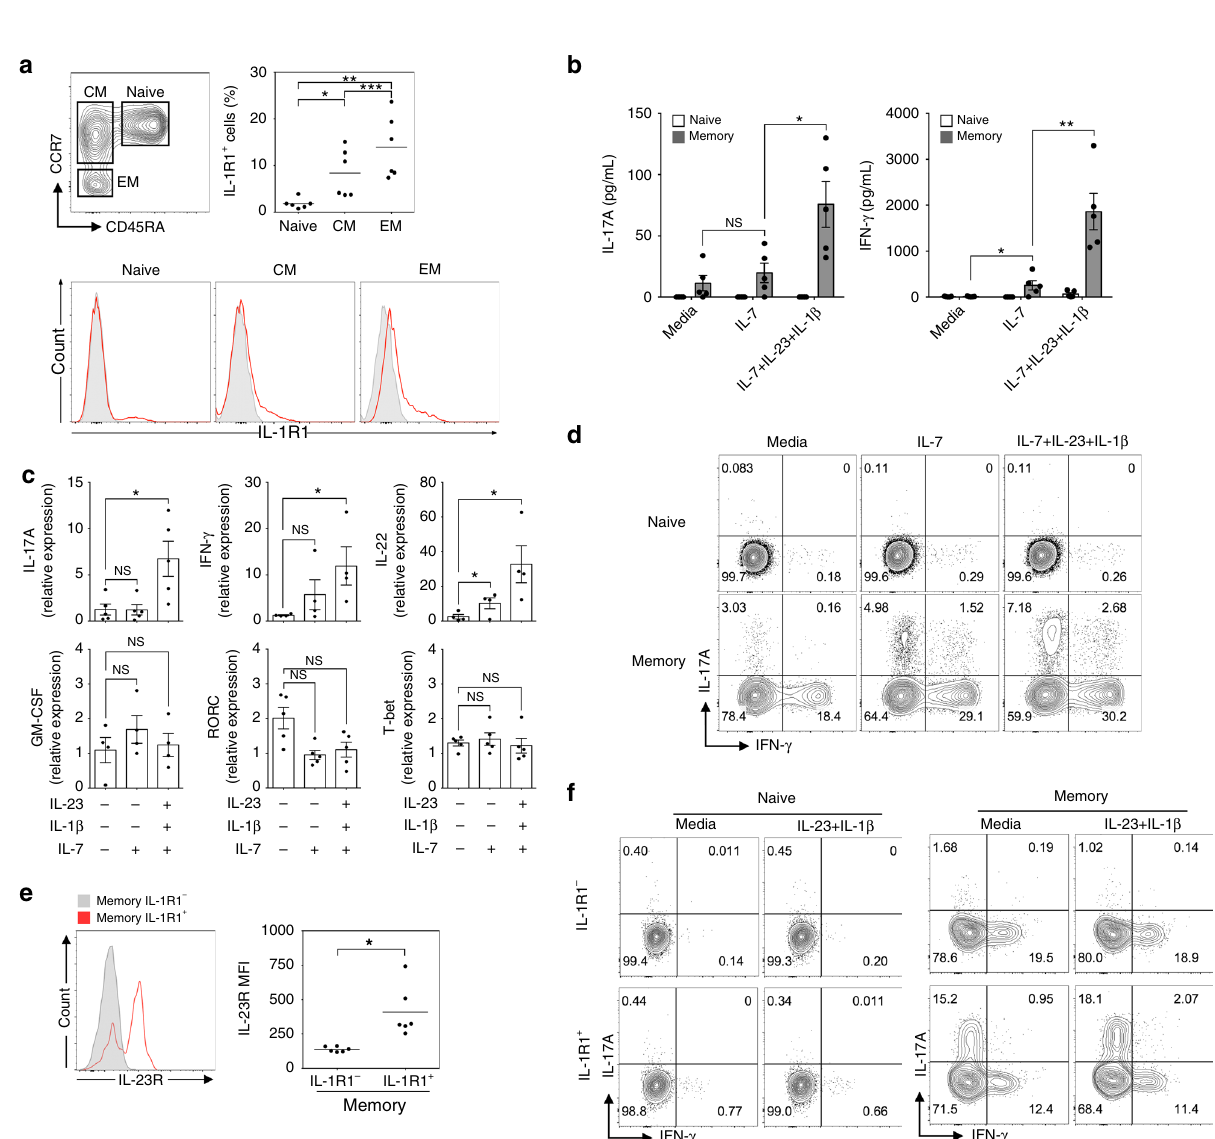
Fig. 7 Human IL-1R1 + memory CD4 + T cells produce IL-17A and IFN- γ in response to IL-1 β and IL-23 without TCR stimulation. a Flow cytometric analysis of IL-1R1 expression in human naive (CD4 + CD25 - CD45RA + CCR7 + ), central memory (CM; CD4 + CD25 - CD45RA - CCR7 + ), and effector memory (EM; CD4 + CD25 - CD45RA - CCR7 − ) T cells. b Human naive and memory (CD4 + CD25 − CD45RA − CCR7 + / − ) T cells were stimulated with IL-1 β and/or IL-23 in the presence of IL-7 for 5 days. IL-17A and IFN- γ concentrations in the supernatants were measured by ELISA. c Human memory CD4 + T cells were cultured with combinations of IL-1 β , IL-23, and IL-7 for 3 days. The levels of mRNAs encoding transcription factors and cytokines were analyzed by quantitative real- time PCR. d The frequency of IL-17A and IFN- γ producing human naive and memory CD4 + T cells was analyzed by fl ow cytometry. e IL-23R expression in human IL-1R1 + and IL-1R1 − memory CD4 + T cells was analyzed by fl ow cytometry. f IL-1R1 + and IL-1R1 − cells were sorted from human naive and memory CD4 + T cells, stimulated with IL-1 β and IL-23 for 5 days, and the frequency of IL-17A and IFN- γ producing cells was determined. Data are presented as the mean ± SEM of six ( a , e ) or at least three ( b – d , f ) independent experiments. NS, not signi fi cant; * p < 0.05, ** p < 0.01, *** p < 0.001